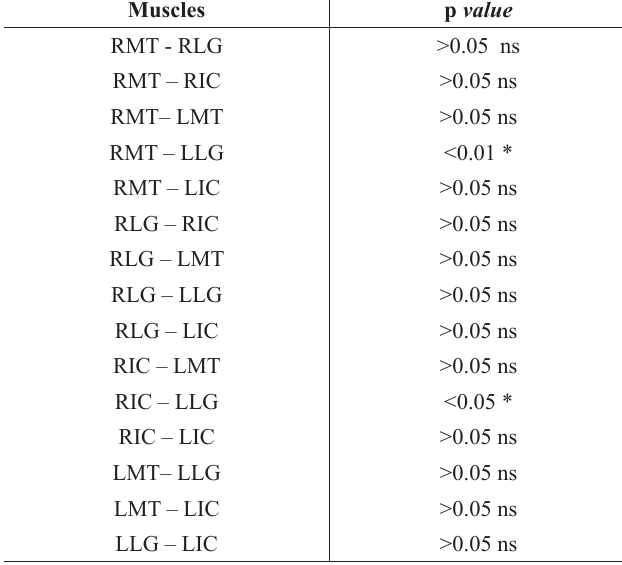
4. Comparative analysis between the the multifidus muscle (MT), lumbar longissimus (LG) and iliocostalis (IC) on the right side (R) and left (L) of 20 volunteers values for values of SCRMS – time domain ( n = 60) obtained during the Sorensen